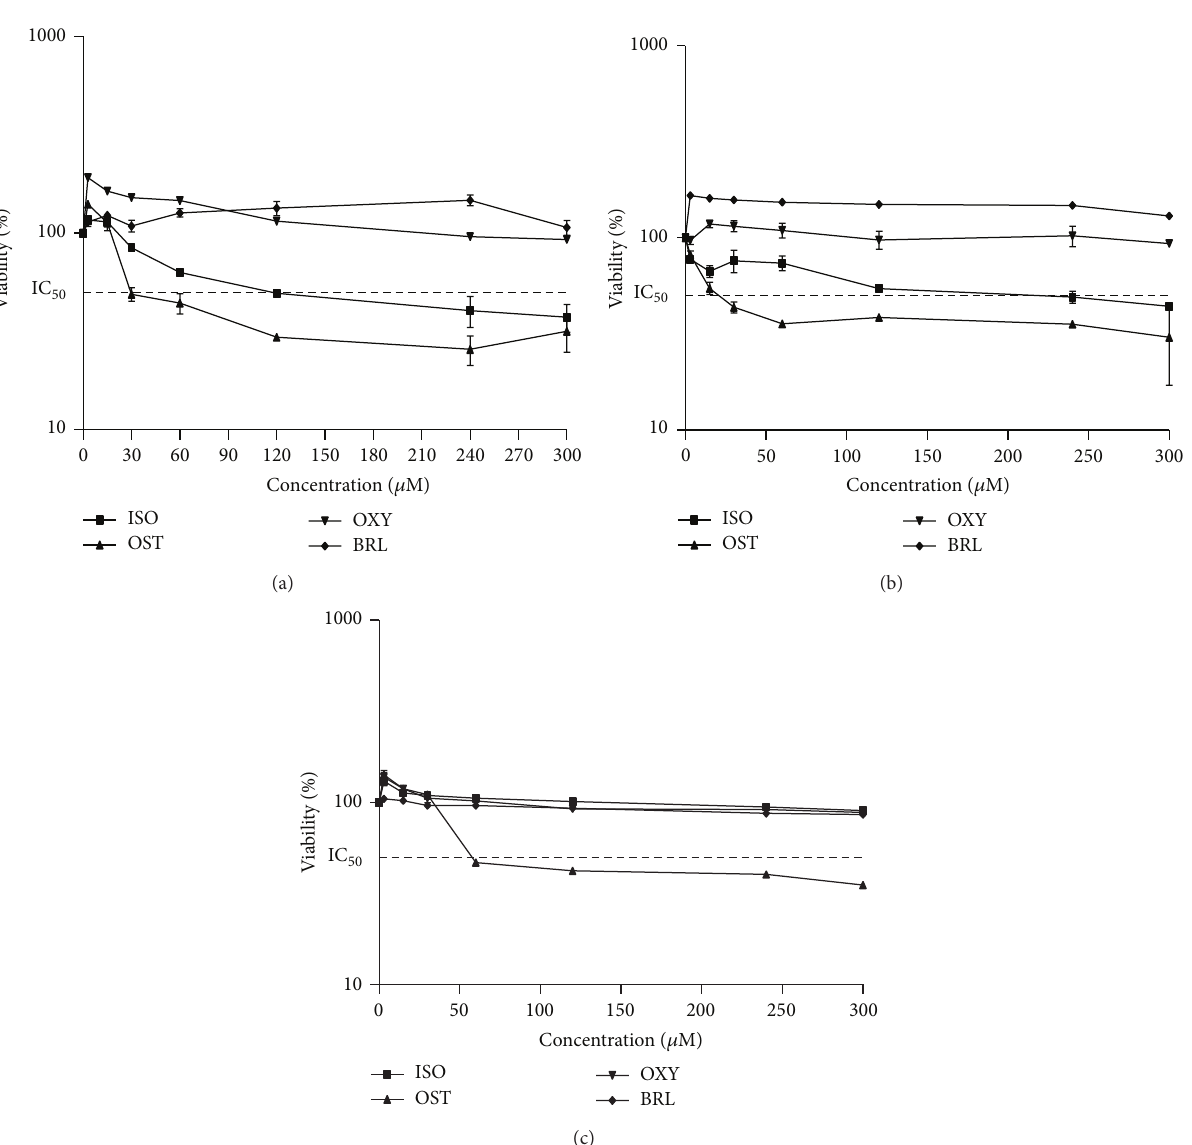
Figure 2: Cytotoxic effects of four isolated coumarins in (a) SKNMC, (b) PC3, and (c) H1299 cancer cells. The cells were incubated with at different concentrations of coumarins for 24 h. The cell proliferation inhibition was determined by MTT assay as described under materials and methods. Data are presented as mean ± S.E.M ( 𝑛 = 3